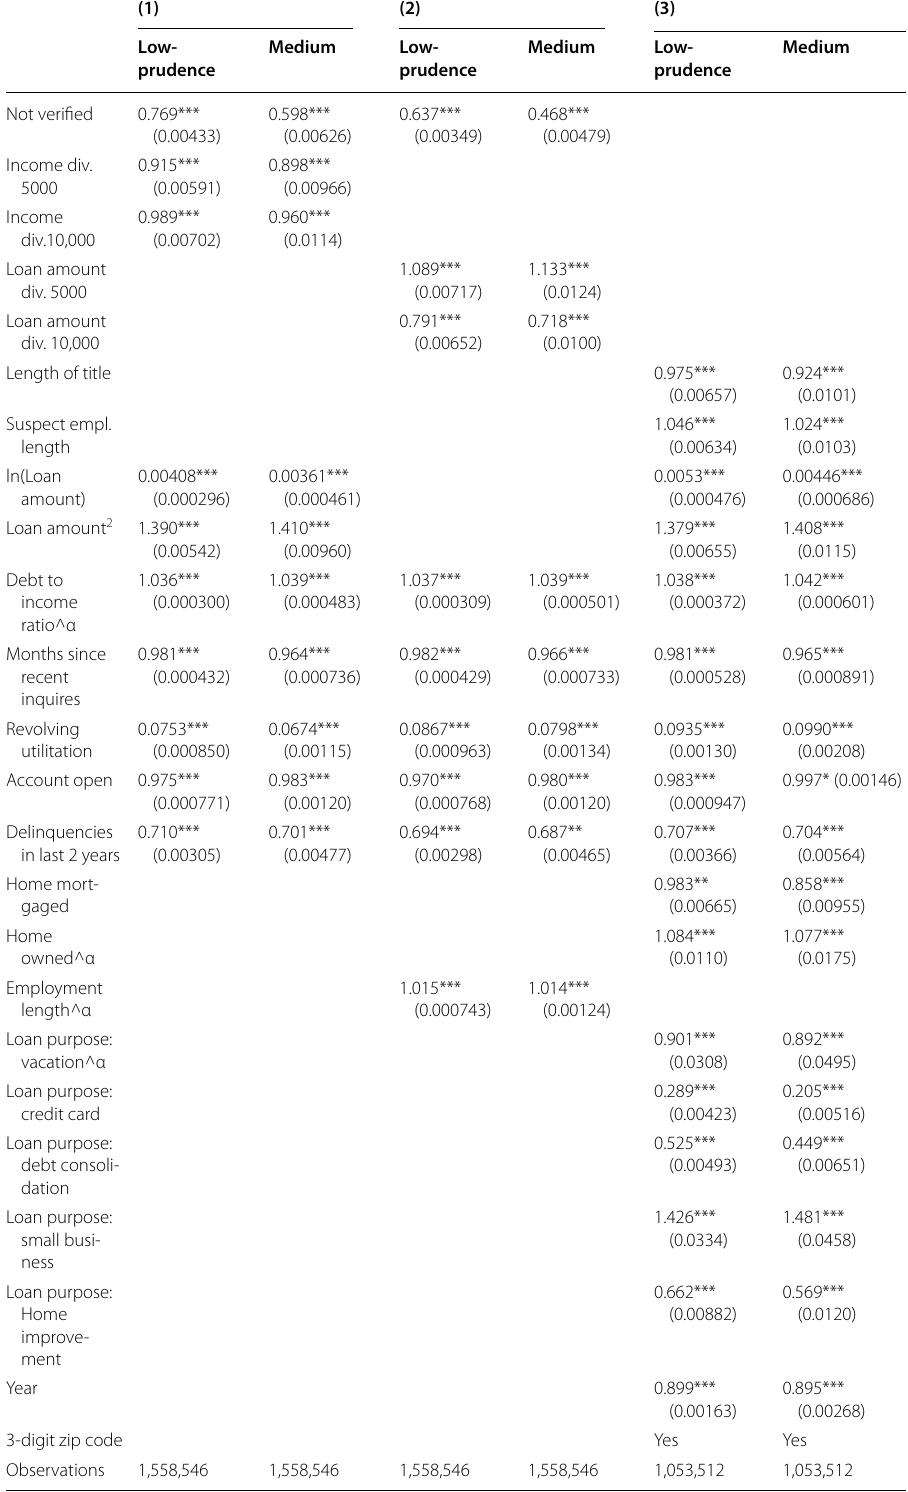
Table 4 Regressions